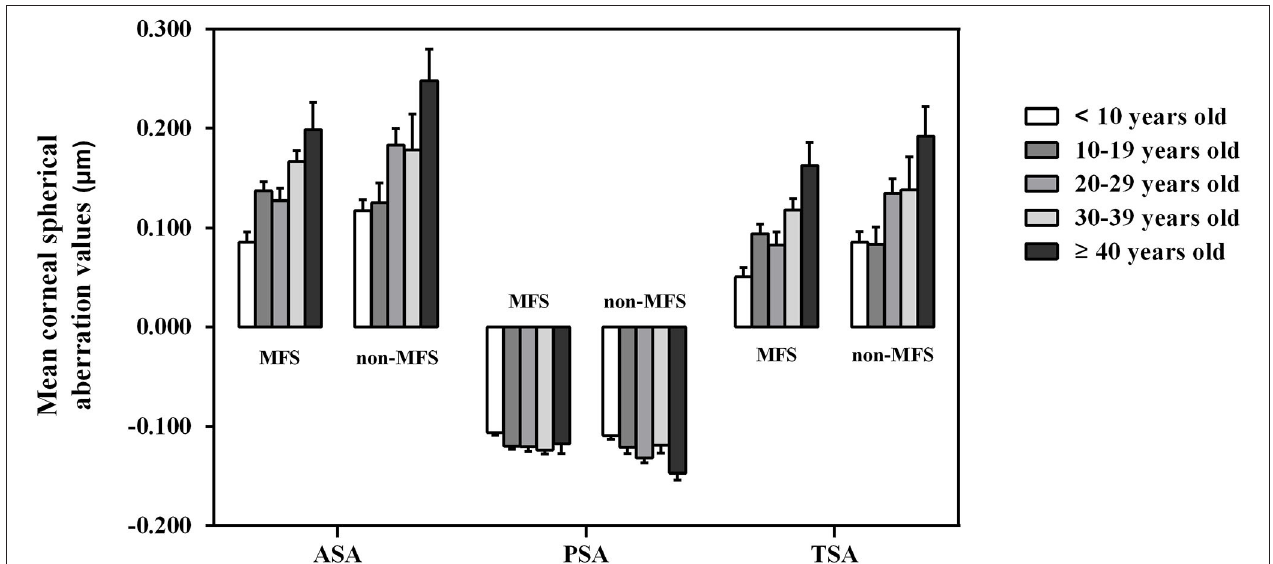
FIGURE 2 | Comparisons of anterior, posterior, and total spherical aberrations of cornea among the five age groups of the patients with bilateral ectopia lentis divided by Marfan and non-Marfan syndrome groups. Error bars represent the standard error of the mean. ASA, anterior spherical aberration; MFS, Marfan syndrome; PSA, posterior spherical aberration; TSA, total spherical aberration.